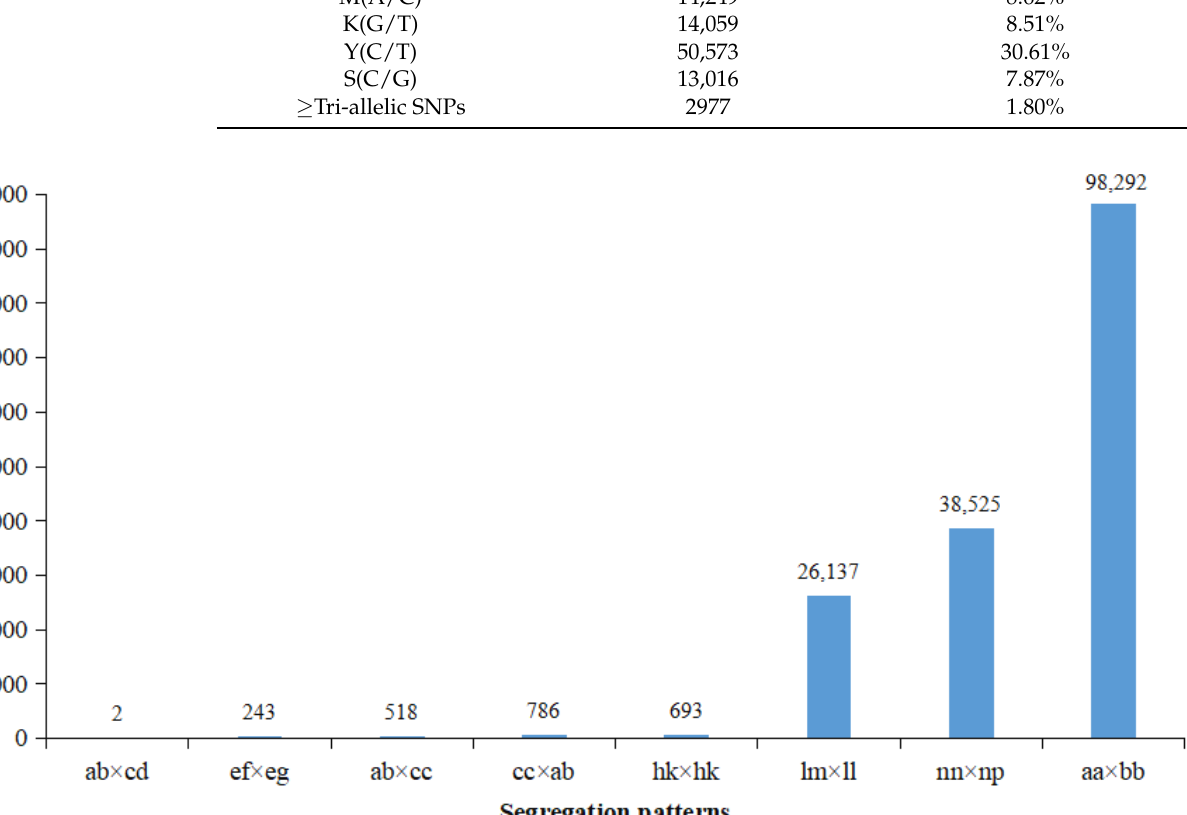
Table 3. Results of transcriptomes assembly from two Paphiopedilum parents and F1 offspring.